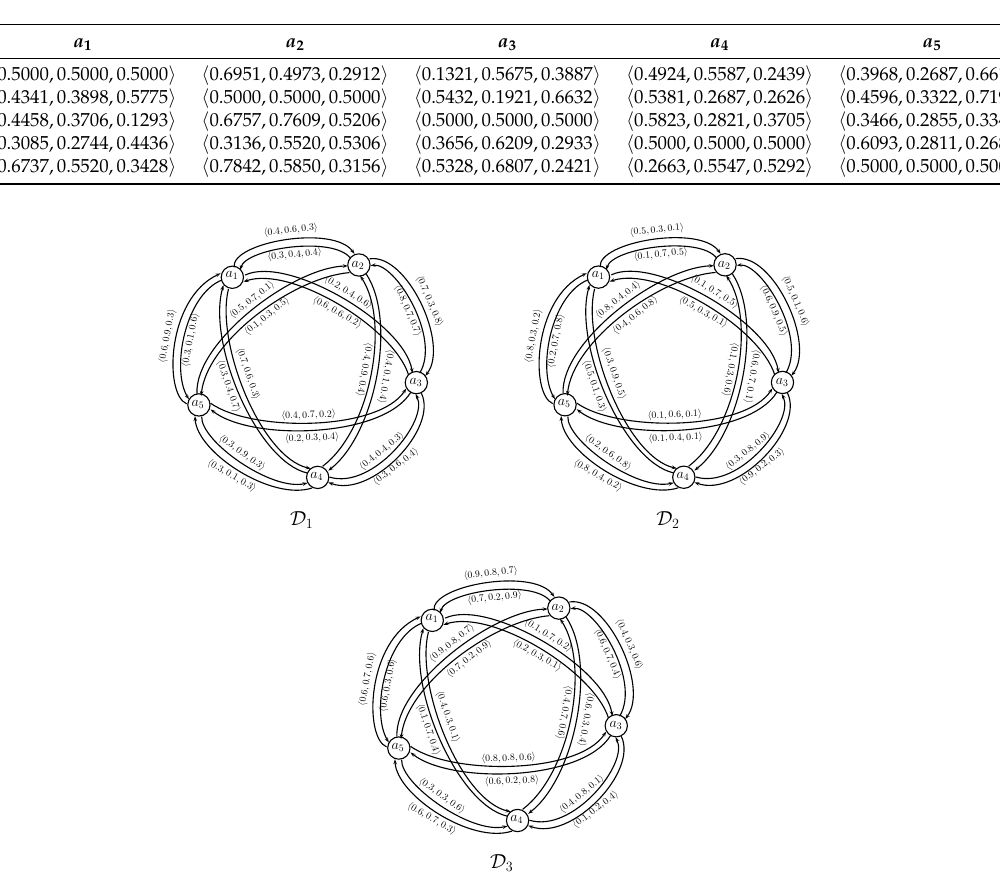
Figure 4. Single-valued neutrosophic digraphs.